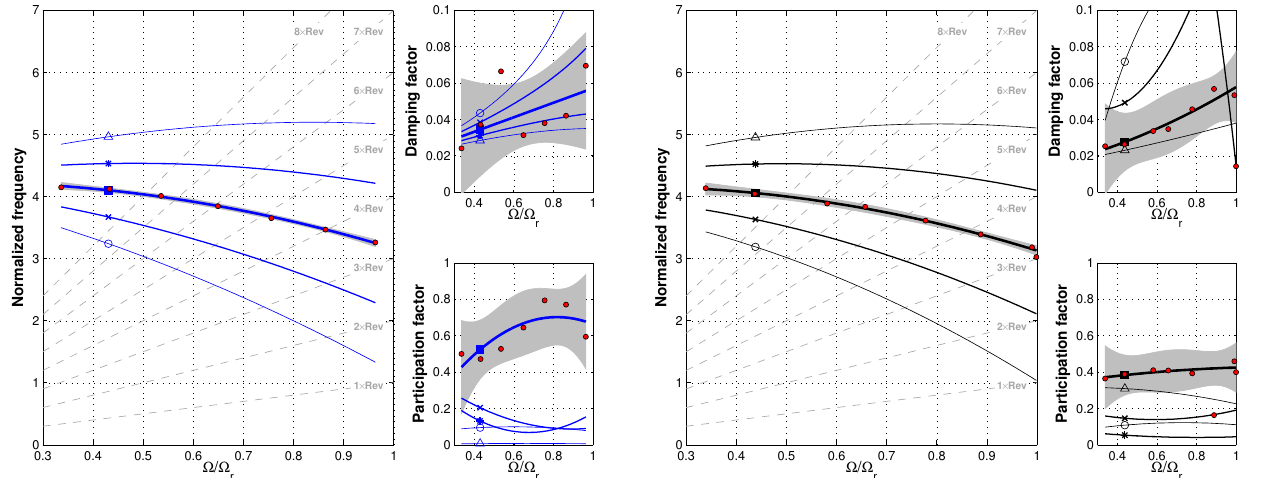
Figure 10. Periodic Campbell diagram of the backward whirling in-plane mode obtained from PARMAX (left) and POMA (right) identifi- cations.